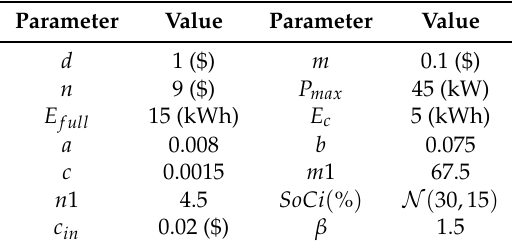
Table 1. Fast charging stations (FCS) and electric vehicles(EV) input parameters.